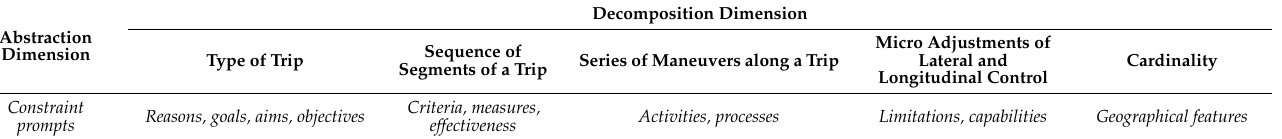
Table 6. Levels of the abstraction hierarchy for capturing the multi-faceted factors of route